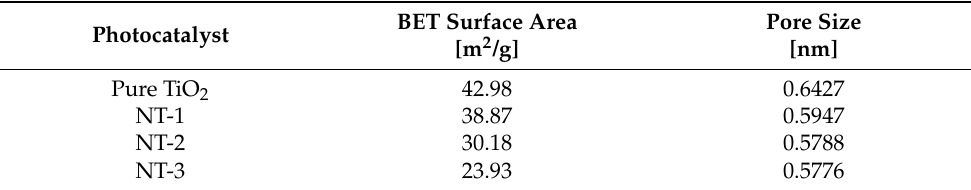
Figure 7. PL spectra of ( a ) Pure TiO 2 , ( b ) NT-1, ( c ) NT-2 and ( d ) NT-3. Table 1. Textural properties of pure TiO 2 , NT-1, NT-2 and NT-3, synthesized by using 0.0, 0.983, 1.965 and 2.940 of urea,